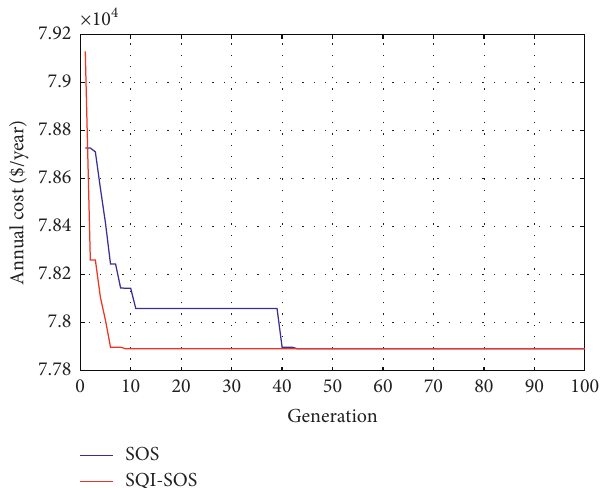
Figure 13: Convergence curves of the total cost of the 69-bus system with the mixed load model.